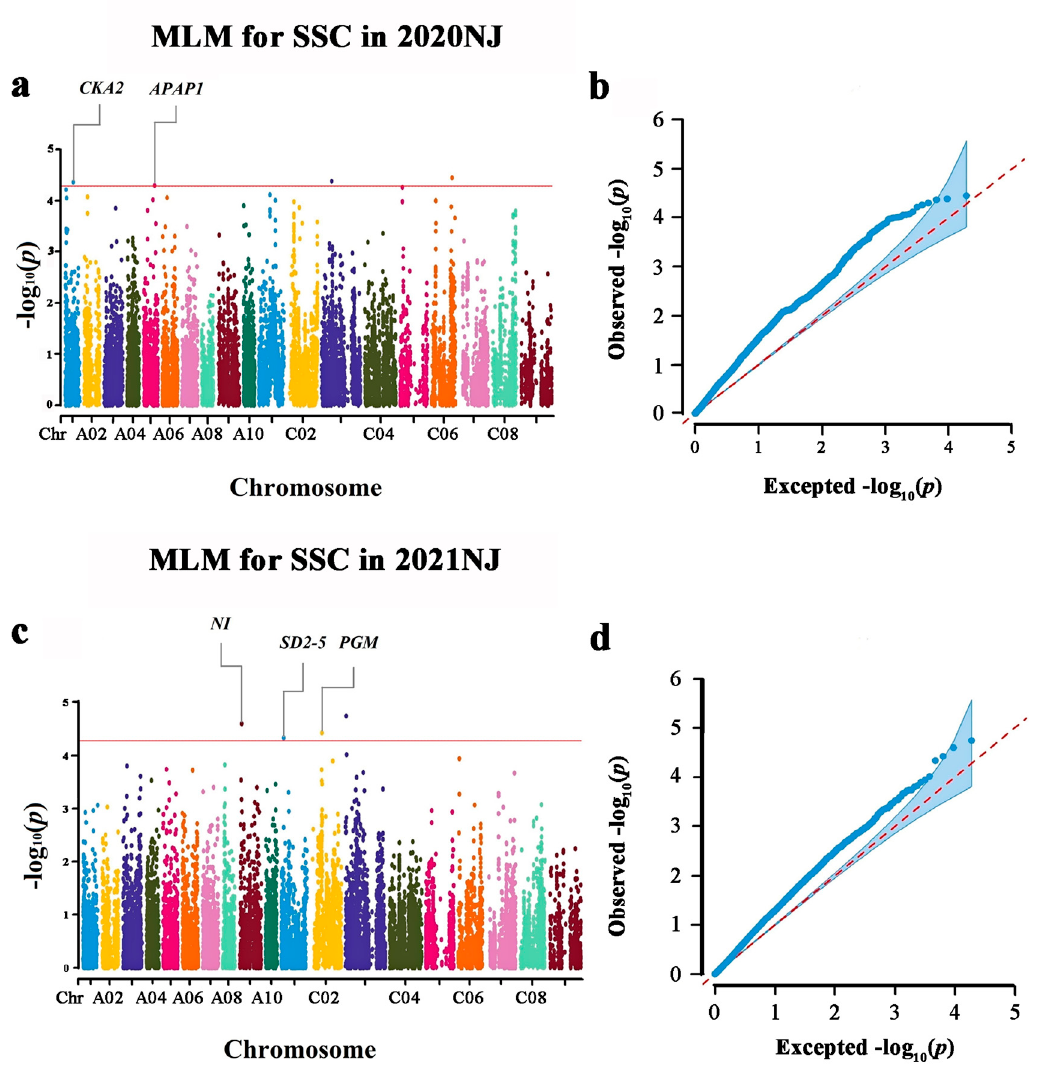
Figure 2. Genome-wide association study of B. napus shoots SSC. ( a ) Manhattan plot of the MLM for SSC in 2020 NJ; ( b ) Quantile–Quantile plot of the MLM for SSC; ( c ) Manhattan plot of the MLM for SSC in 2021 NJ; ( d ) Quantile–Quantile plot of the MLM for SSC. The red rings represent the suggestive threshold of − log10( p ) = 4.28. GWAS loci are indicated above the threshold, and the corresponding genes are annotated. If more than one candidate gene was identified within the observed linkage disequilibrium decay of one locus, the most likely candidate gene is annotated in the Manhattan plot. Full gene information is provided in Table 4.